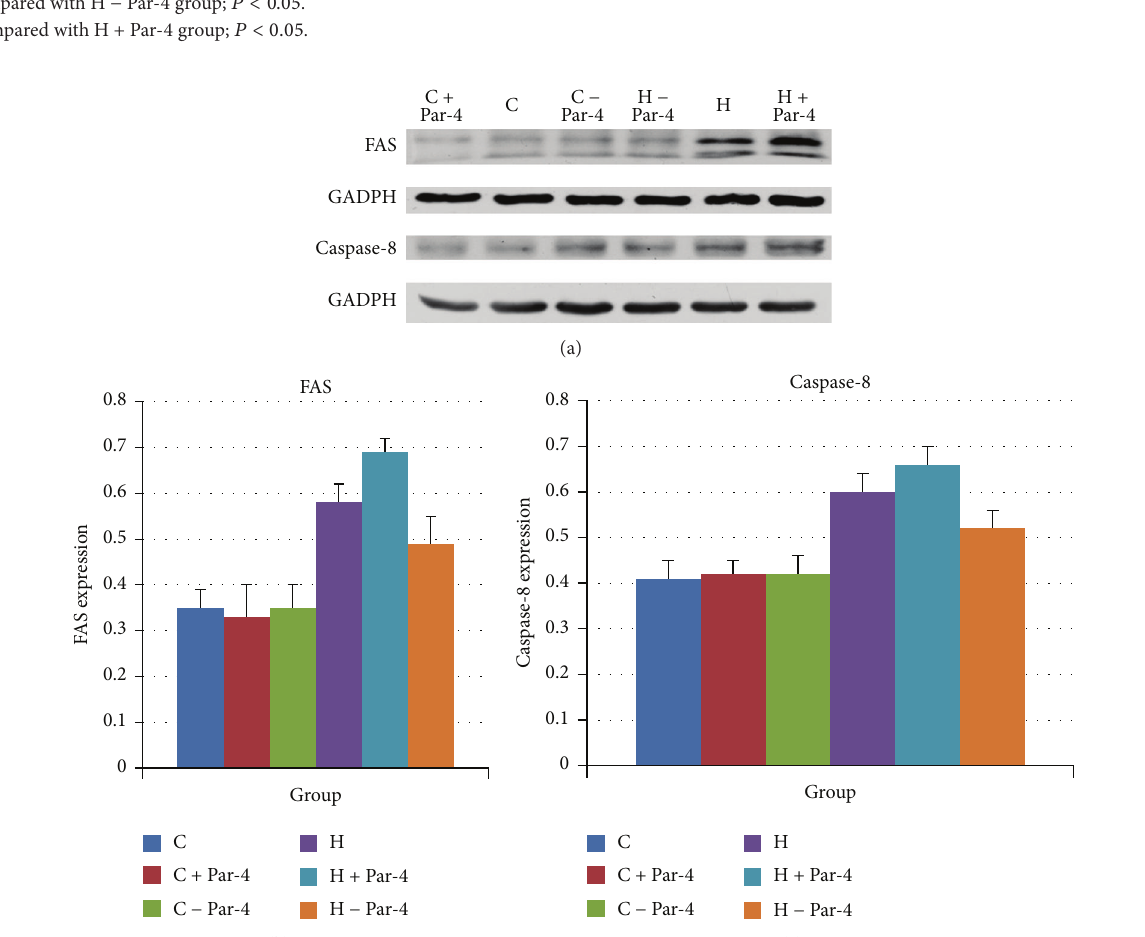
Figure4:GlucoseandpalmitatecointerventionactivatesPar-4andmediatesthecellmembraneapoptoticpathwaytoinduceNIT-1apoptosis.